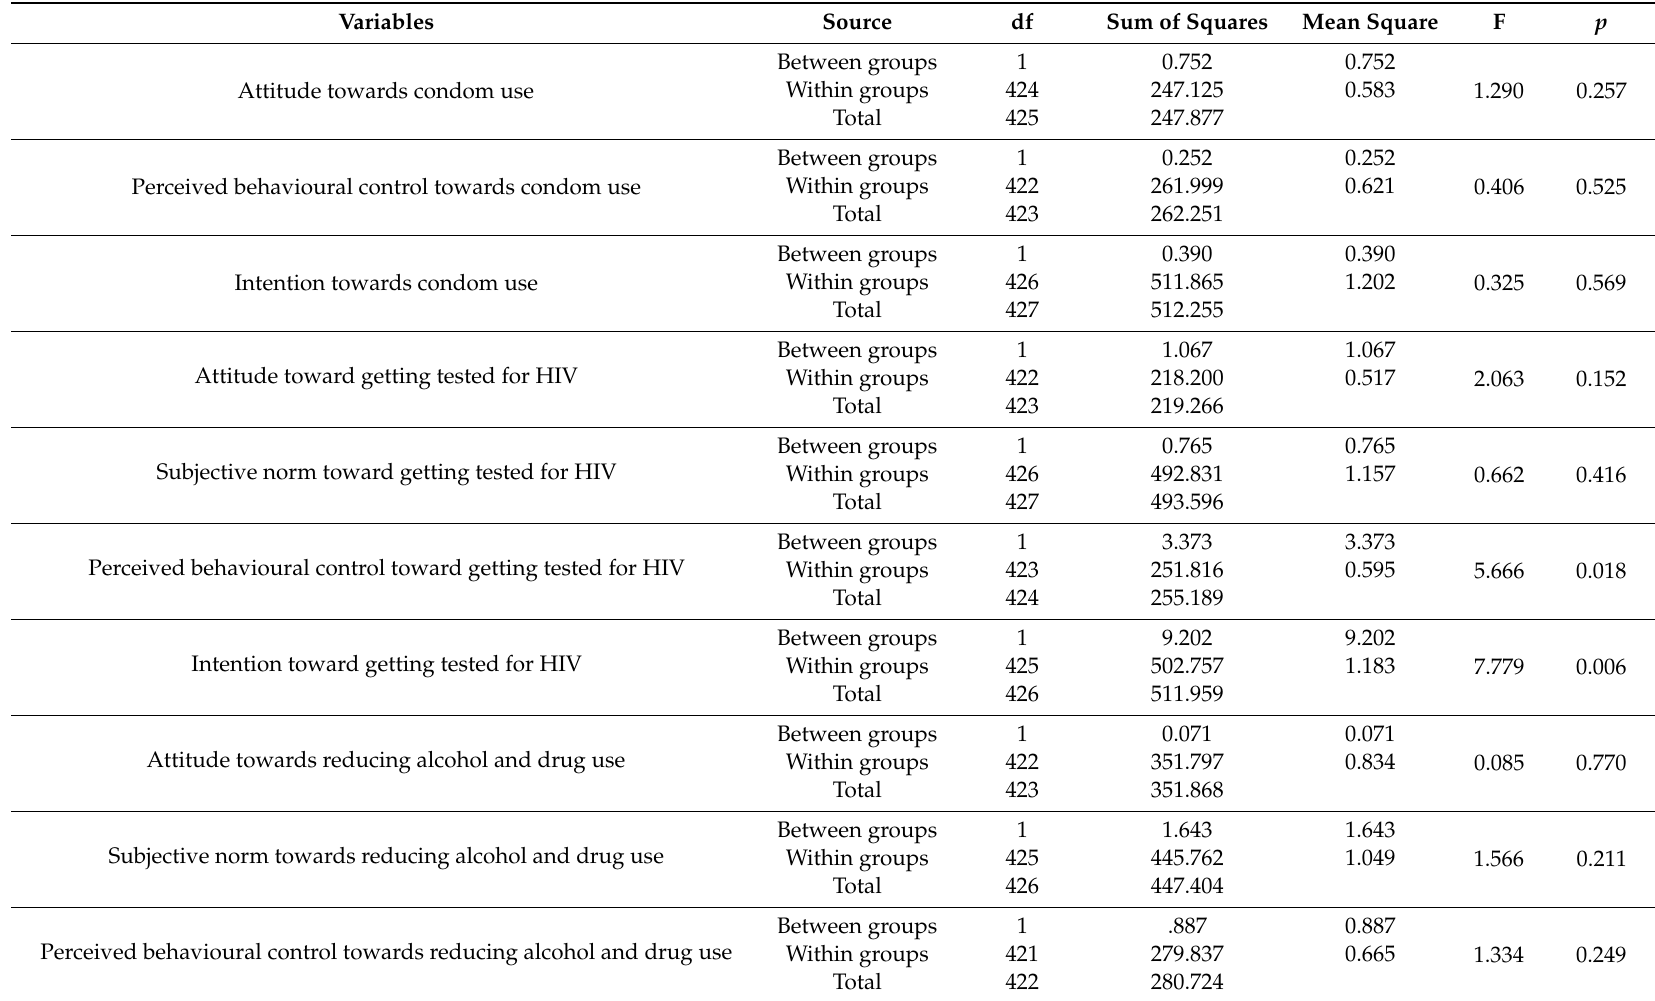
Table 3. Bivariate results of Study 1 experiment and control means at